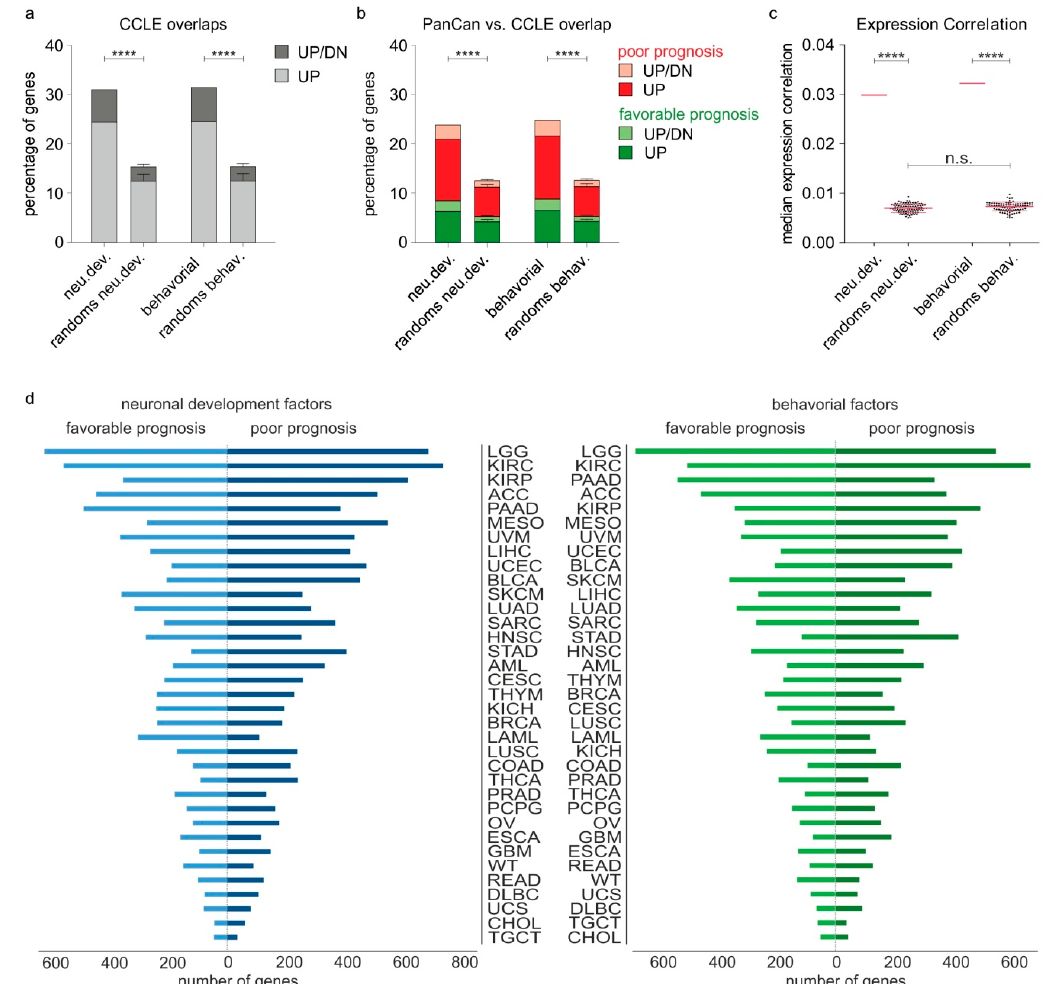
Figure 2. Nervous system-related gene transcripts are upregulated in invasive stages and predict clinical outcomes in a cancer type-dependent manner. ( a ) Transcripts of both neu.dev and behavioral genes are upregulated in the highly invasive versus the less invasive CCLE cell lines, in a percentage higher than the corresponding percentages of the control lists. Light gray depicts the genes that are upregulated across all cancer types, while the dark gray depicts the genes that show cancer type-dependent upregulation. ( b ) Cox regression analysis of the nervous system-related genes that are upregulated in invasive cell lines of CCLE on the survival of the TCGA PanCan cohort patients. Genes that correlate with poor prognosis and are upregulated in aggressive states of CCLE are depicted in red (UP, exclusively upregulated in all cancer types) or pink (UP / DN, upregulated in some as well as downregulated in other cancer types). The ones that correlate with favorable prognostic factors are depicted in dark (UP) or light green (UP/DN). ( c ) Shown are the medians of expression correlation (MEC) in PanCan within each gene list of the neu.dev, the behavioral and the respective 100 random gene lists (mean with SD pink lines). MEC are significantly higher among neu.dev and behavioral genes compared to their respective random lists. ( d ) Survival analysis for neu.dev (left, blue) and behavioral (right, green) genes across different TCGA cancers. The prognostic potential of each nervous system-related gene depends on the cancer type. In the majority of cancer types, more nervous system-related genes are associated with poor and less with favorable prognosis. Z-test was used for statistical analyses; **** p < 0.0001, n.s.: non-significant.